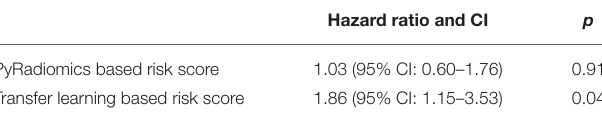
TABLE 3 | Performance of risk score models in Cox Proportional Hazard analysis.